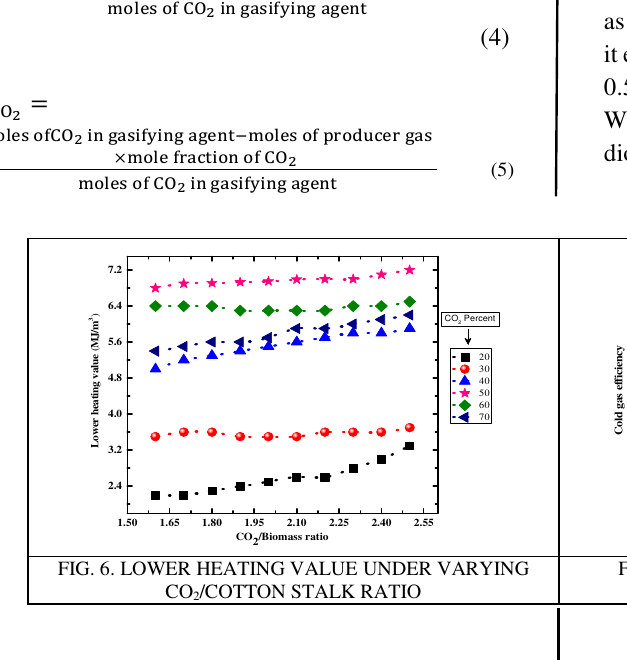
FIG. 6. LOWER HEATING VALUE UNDER VARYING CO 2 /COTTON STALK RATIO